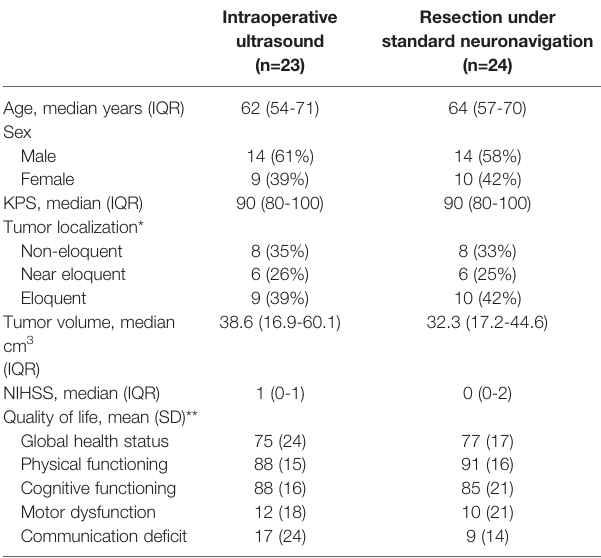
TABLE 1 | Baseline